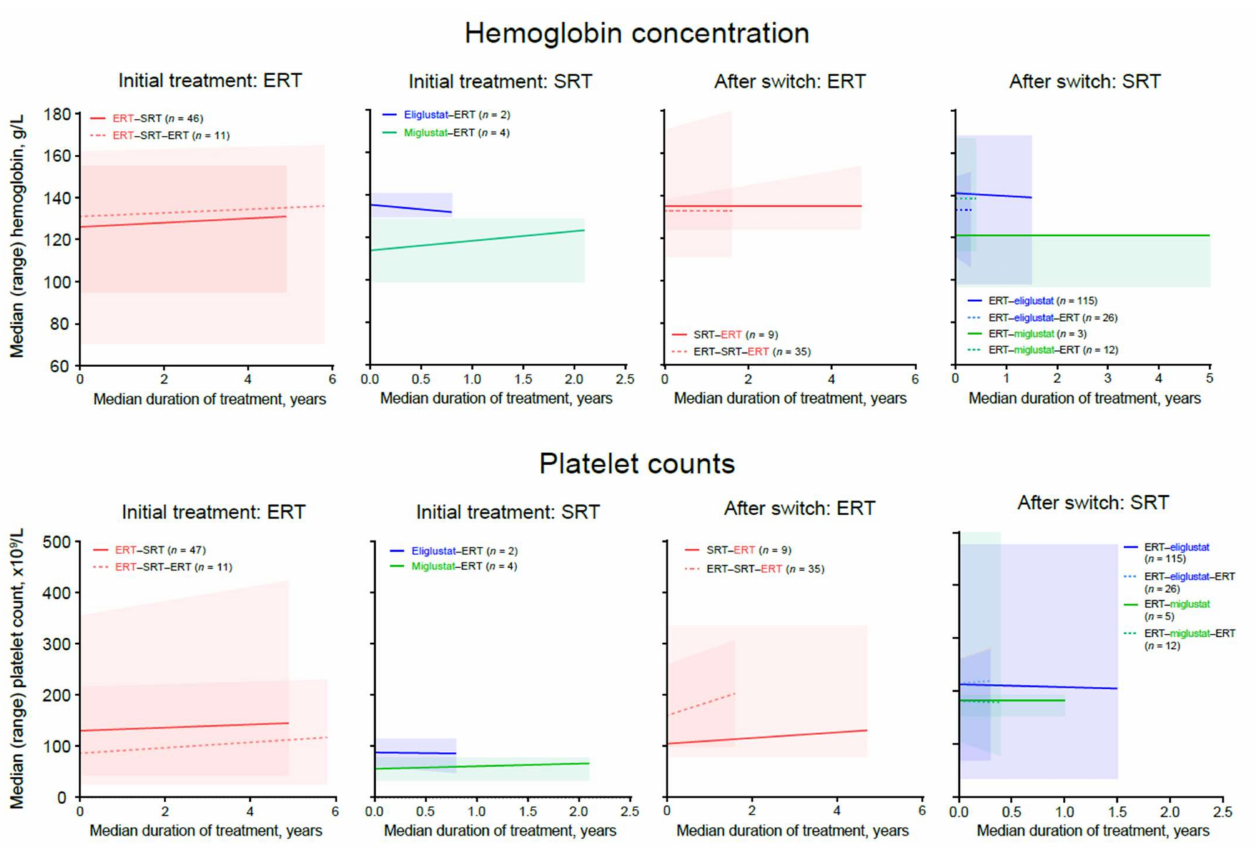
Figure 4. Change in median (range) hemoglobin concentrations and platelet counts before and after